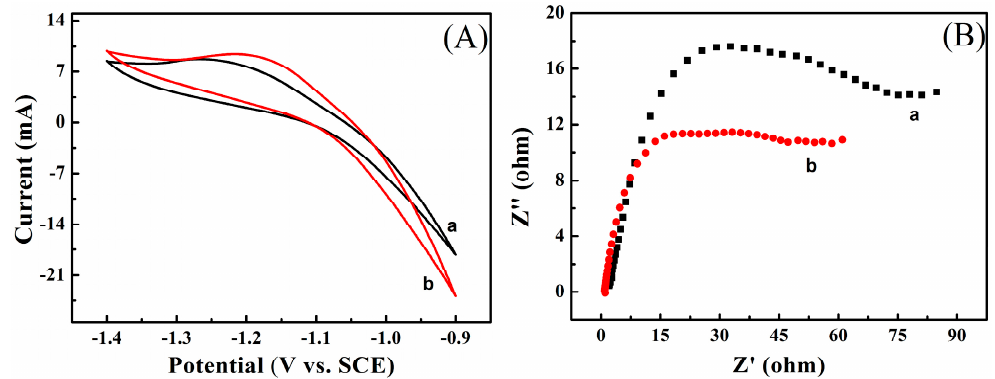
Figure 7. CV ( A ) and EIS ( B ) of the zinc electrode in the aqueous electrolyte containing 0.1 M sodium propionate (curve a) or 0.2 M disodium malonate (curve b).